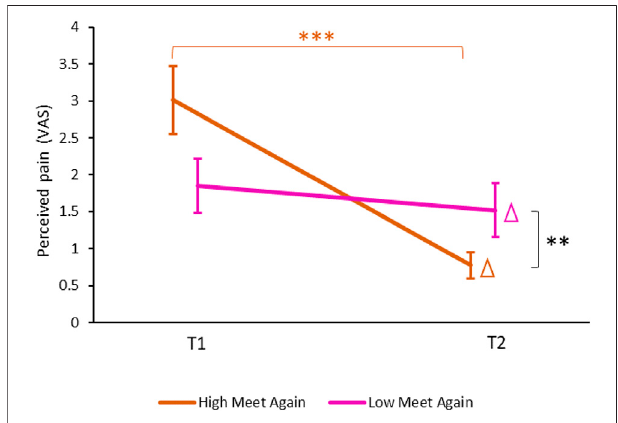
FIGURE 7 | Differences in pain ratings between HMA and LMA. Only in the HMAsub-group(brown)there wasasigni fi cantdecrease inpain ratingsat T2 compared to T1 (*** p < 0.001). The change in pain ratings from T1 to T2 (marked with a Δ ) was signi fi cantly different between the HMA and the LMA (magenta) sub-groups (** p < 0.01). Values denote mean visual-analogue scale (VAS) ratings (0 – 10) ±SEM.T1 — before encountering PARO, T2 — while touching PARO. HMA — participants who gave above-median ratings to their willingness to meet PARO again. LMA — participants who gave below-median ratings to their willingness to meet PARO